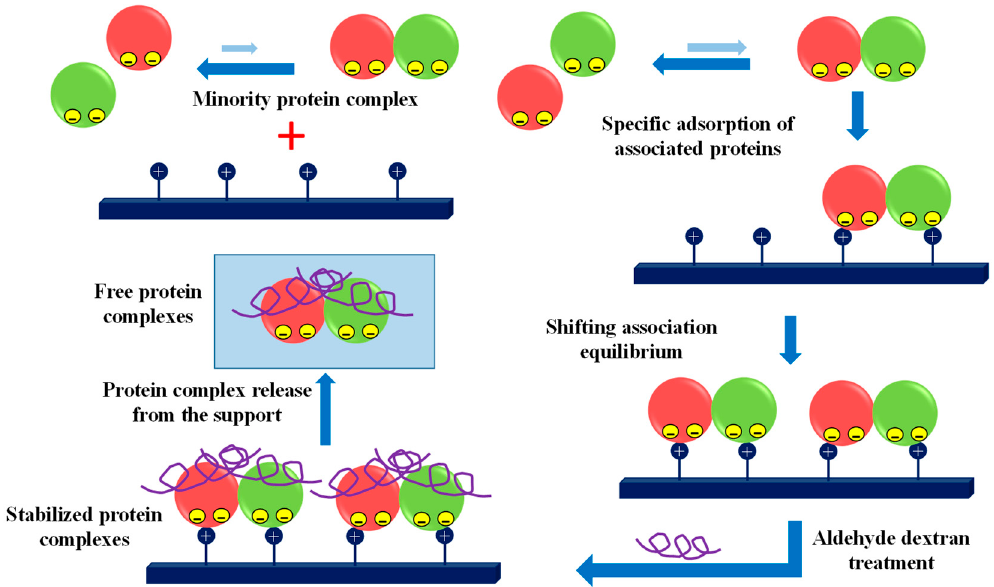
Figure 23. Shifting association equilibrium of weak enzyme complexes using lowly activated supports and final crosslinking of the immobilized complexes with dexOx.